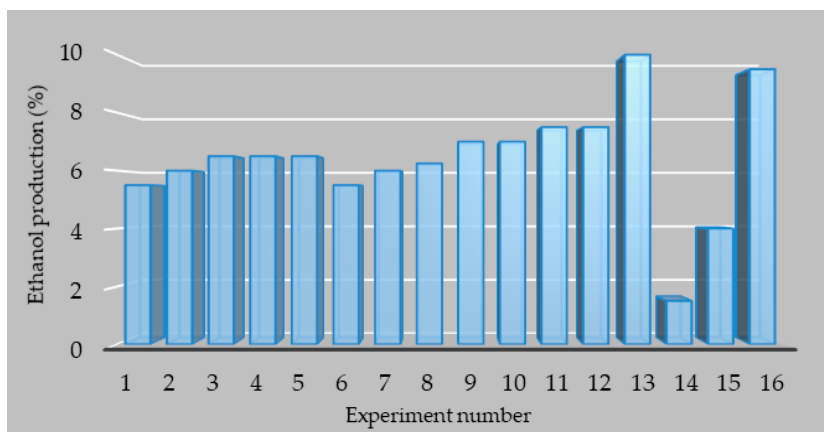
Figure 3. The results of ethanol production by S. cerevisiae sahand 101 in 16 experiments designed by the Taguchi method.